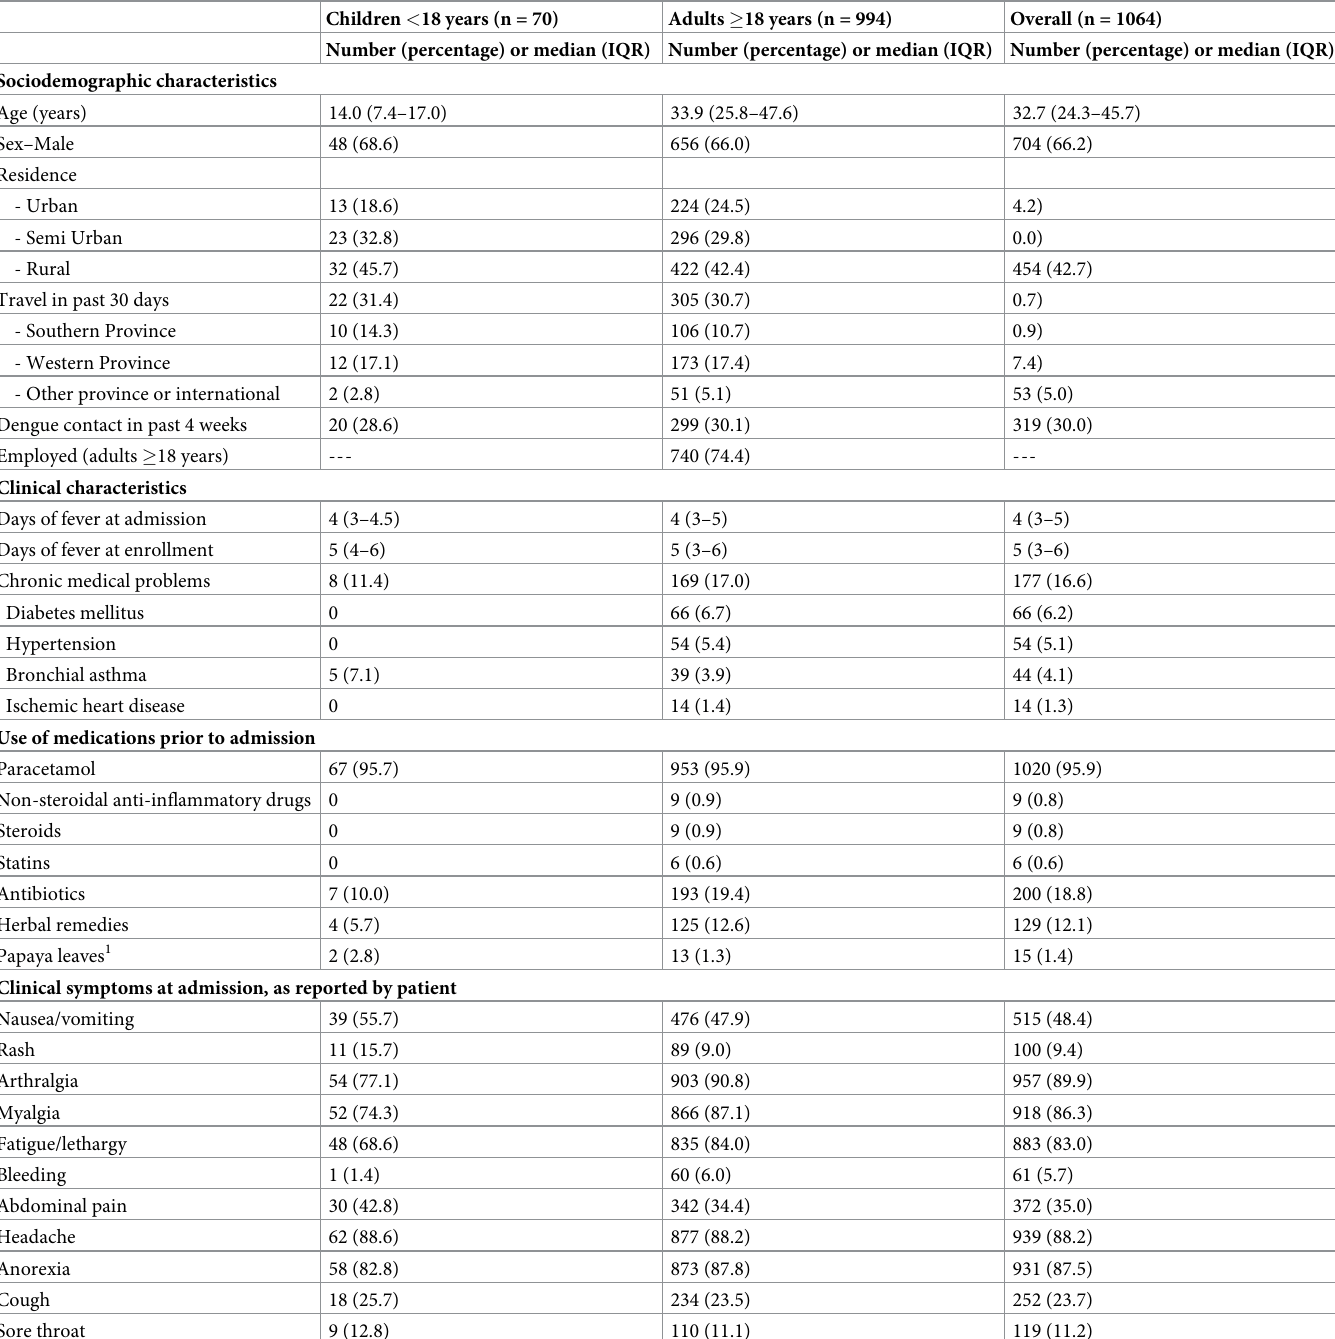
Table 1. Sociodemographic and clinical characteristics of children and adults with acute dengue in Southern Province, Sri Lanka,